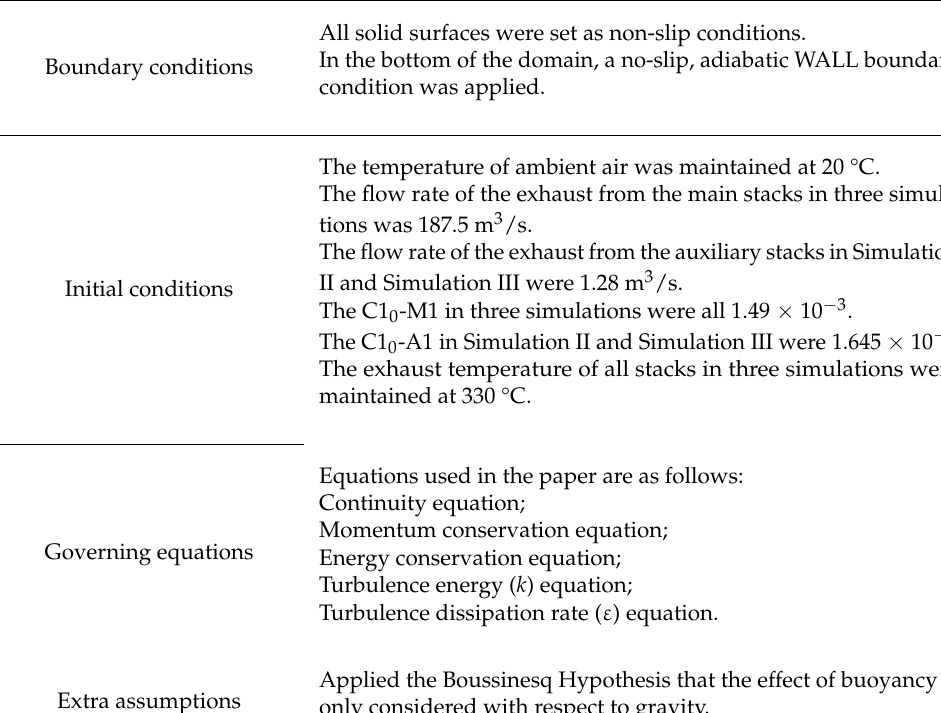
Table 3. Boundary conditions, initial conditions, governing equations, and extra